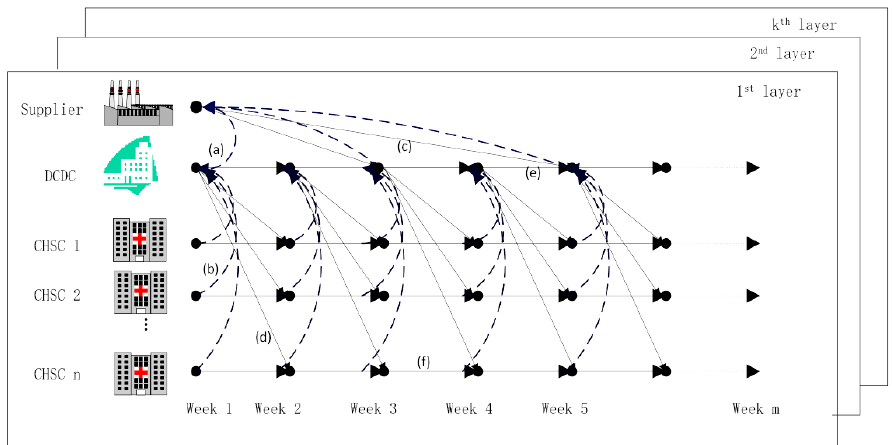
Figure 1. Time-space network of medical resources